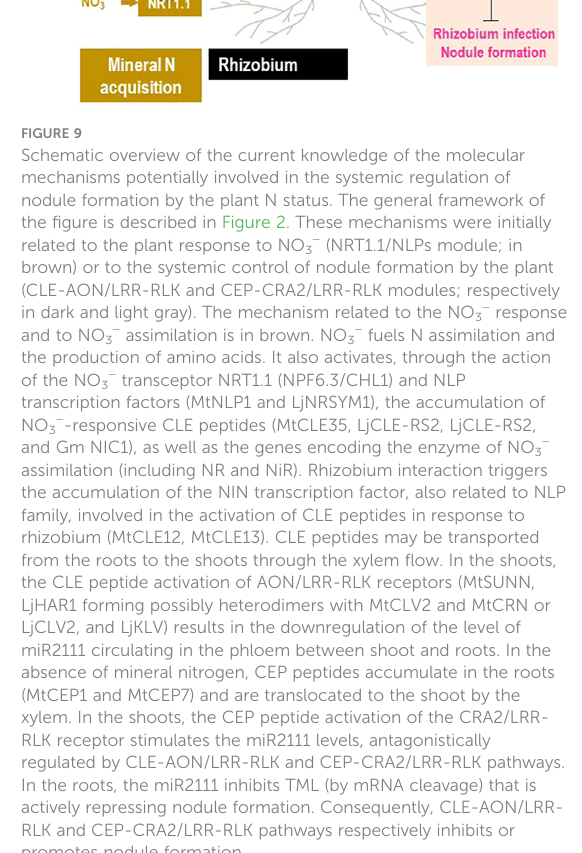
nodulation capacity (Bourion et al., 2014; Huault et al., 2014; Laffont